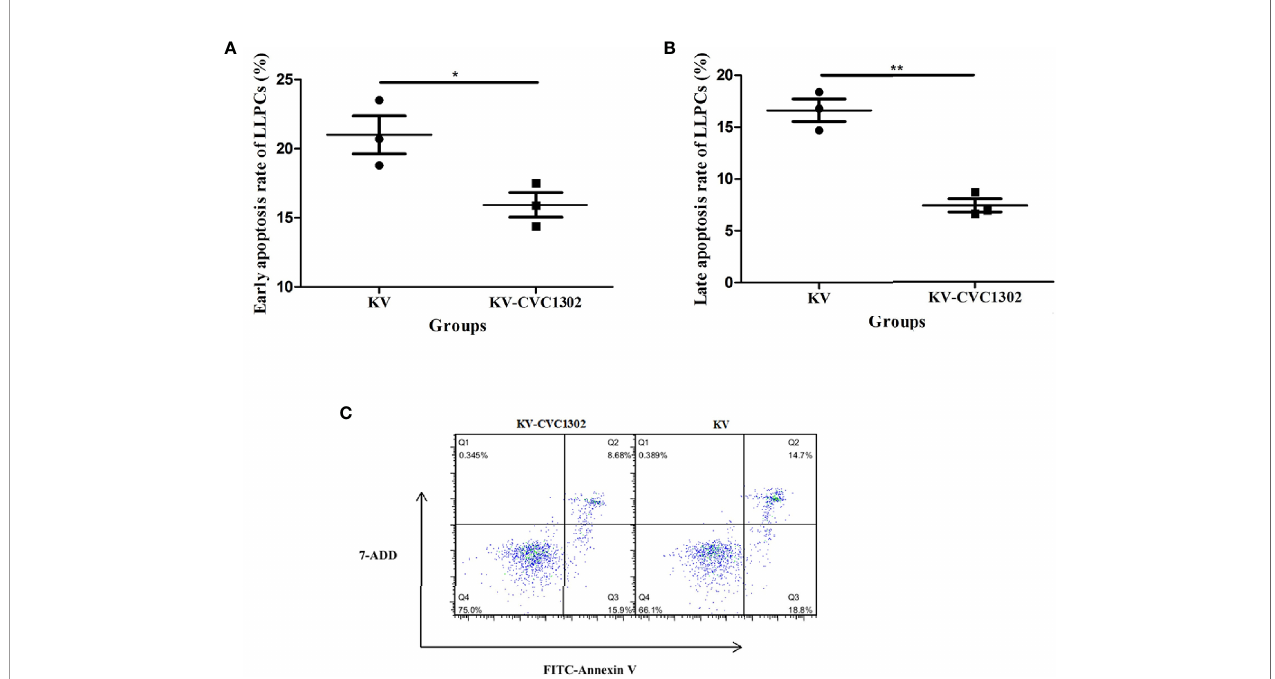
FIGURE 5 | Percentages of early and late apoptosis in LLPs from immunized mice. The percentages of early apoptosis (A) and late apoptosis (B) in LLPCs from mice immunized with KV or KV-CVC1302. (C) The fl ow cytometry gating strategies of the apoptosis of LLPCs. Samples were collected at 90 dpi. Data are presented as the mean ± SEM. * P < 0.05, ** P <